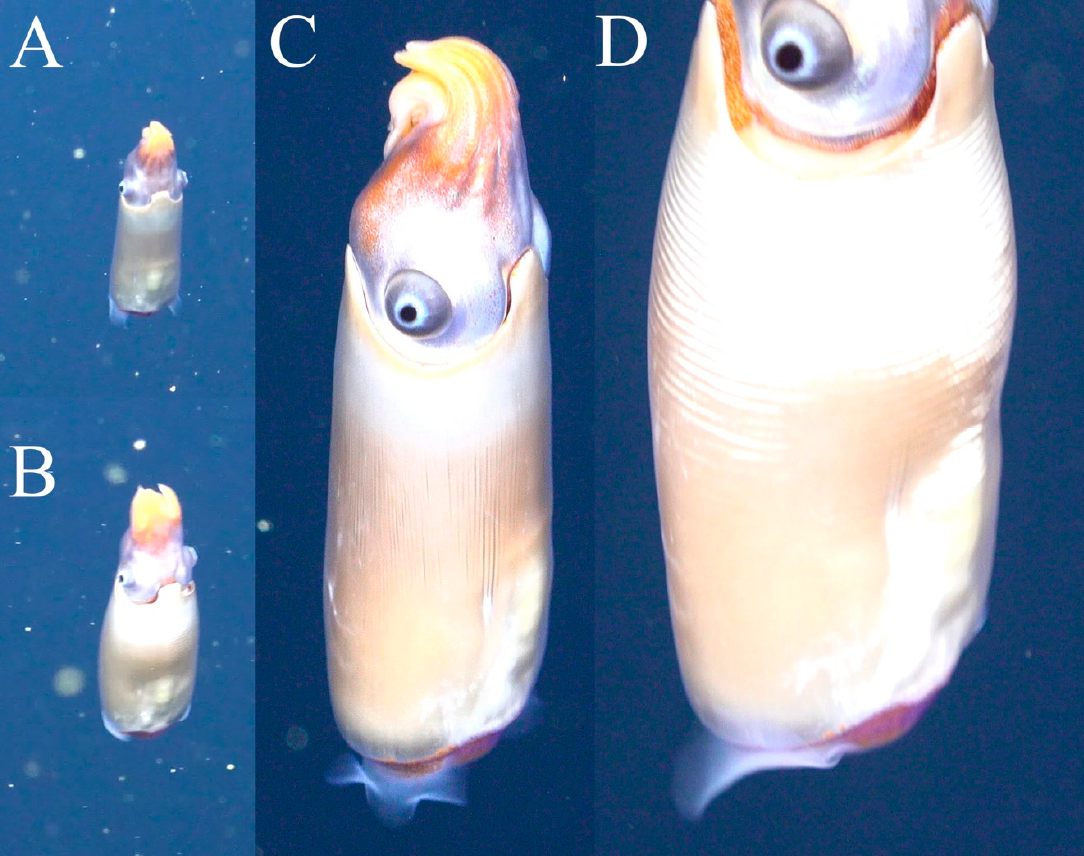
Figure 1. Framegrabs from the 4K video record of Spirula spirula observed in situ: ( A ) resting position with no part of the interior shell visible external to the mantle; ( B ) inflated mantle prior to jetting escape showing the lack of mantle inflation in the area of the internal shell; ( C ) resting position with curled arms; and ( D ) hyperinflated mantle at start of jetting escape.